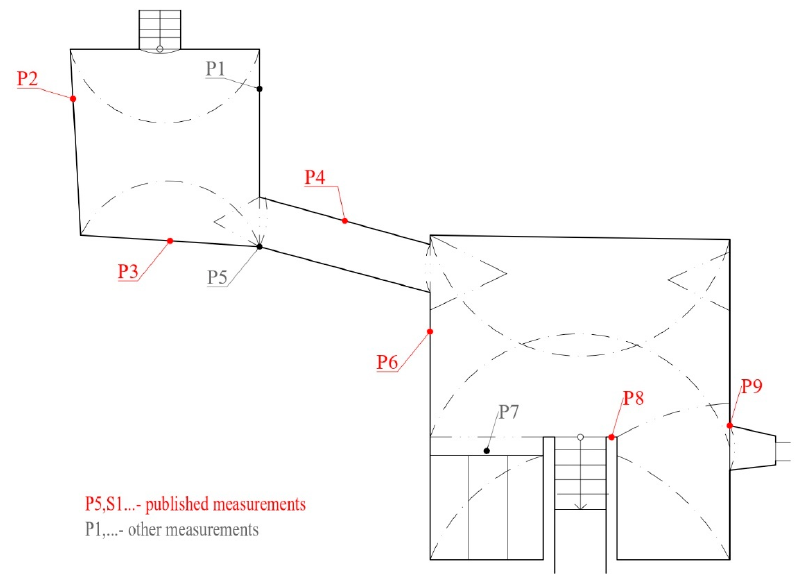
Figure 6. Humidity measurement points (2nd researched building).